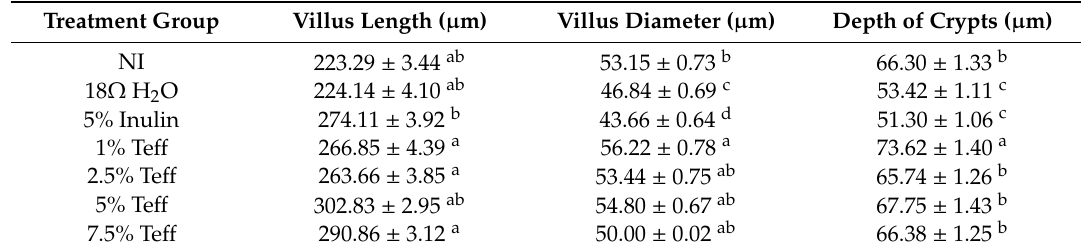
Table 8. E ff ect of the intra-amniotic administration of experimental te ff solutions on duodenal villus and crypts measurements 1 .